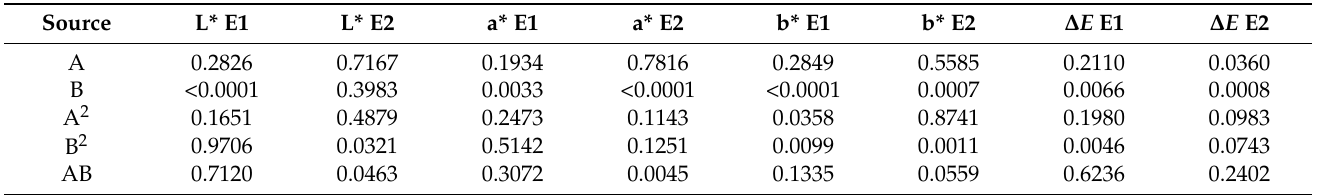
Table 6. Degree of significance ( p -values) of the polynomial regression model coefficients corresponding to each response